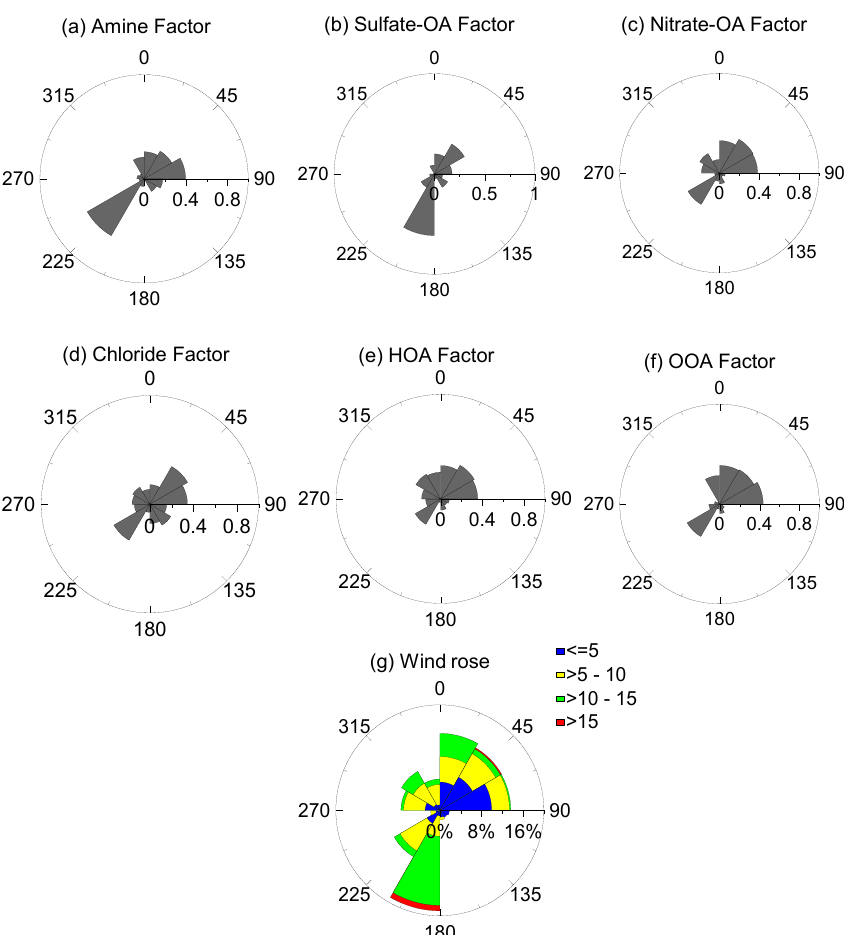
Figure 8. Conditional probability function (CPF) plots for the six factors from the six-factor solution of the PMF Full MS analysis, along with a wind rose plot (wind speed in ms − 1 ). The strongest wind dependence is observed for the Amine and Sulfate-OA factors, which show strong, yet slightly different directional associations to the